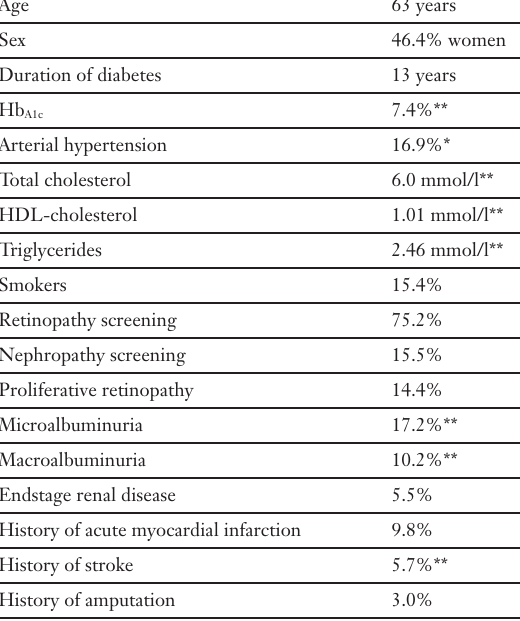
General characteris- tics of the type 2 diabetes cohort analysed [8].